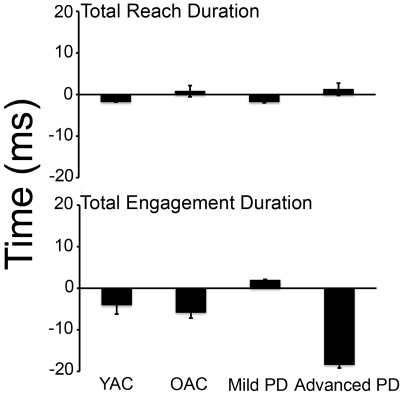
Reach duration (top) and engagement duration (bottom) difference for all experimental groups (no music-music); mean and standard errors.Note that the time to complete total reach duration was not affected by accompanying music, whereas time to complete total engagement duration was decreased for advanced PD subjects.